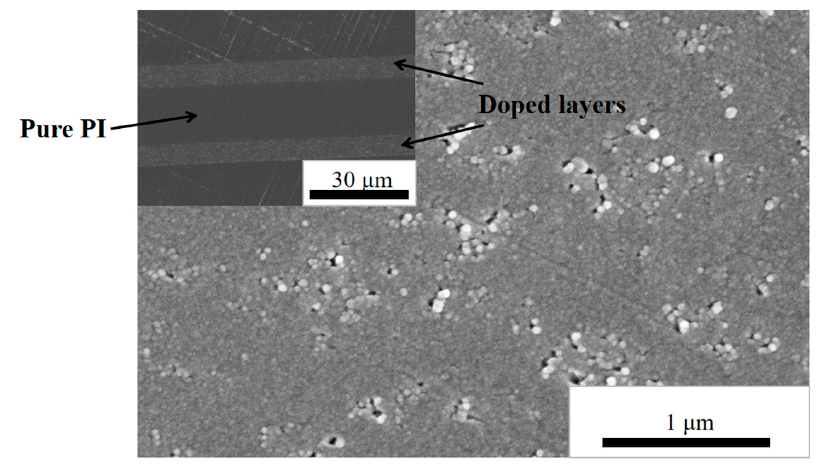
Figure 2. SEM cross-sectional morphologies of PI/nano-SiO 2 three-layer composite films doped with 5 wt%.